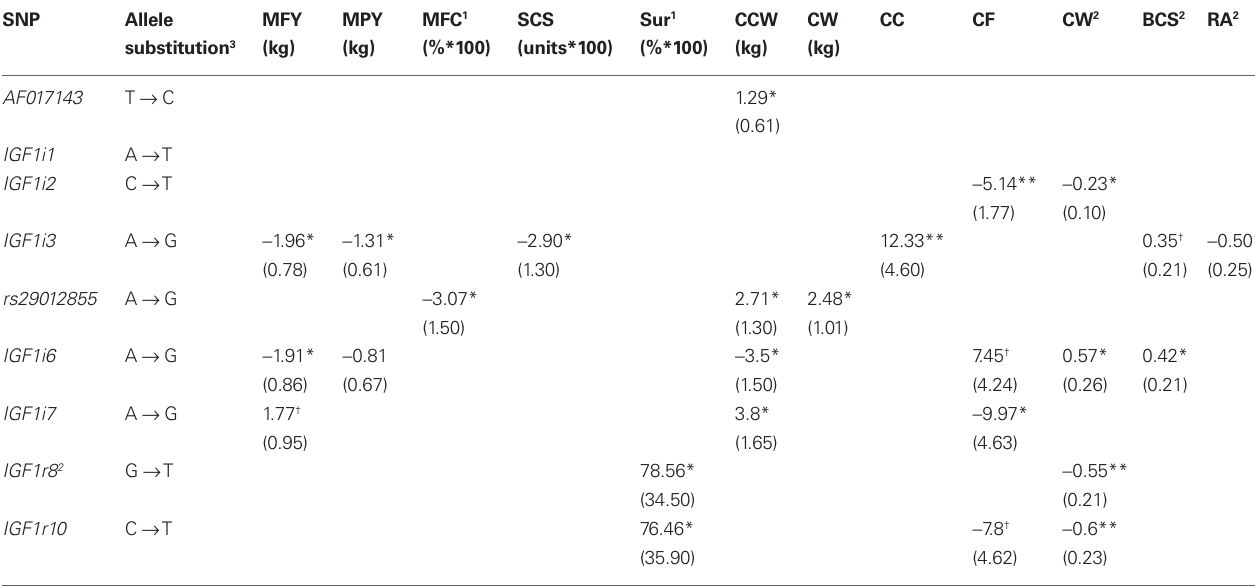
Table 5 | Allelic substitution effect (standard error in parenthesis) between the 11 segregating SNPs and milk production, somatic cell score (SCS), survival, carcass, and body size traits when included individually in the statistical